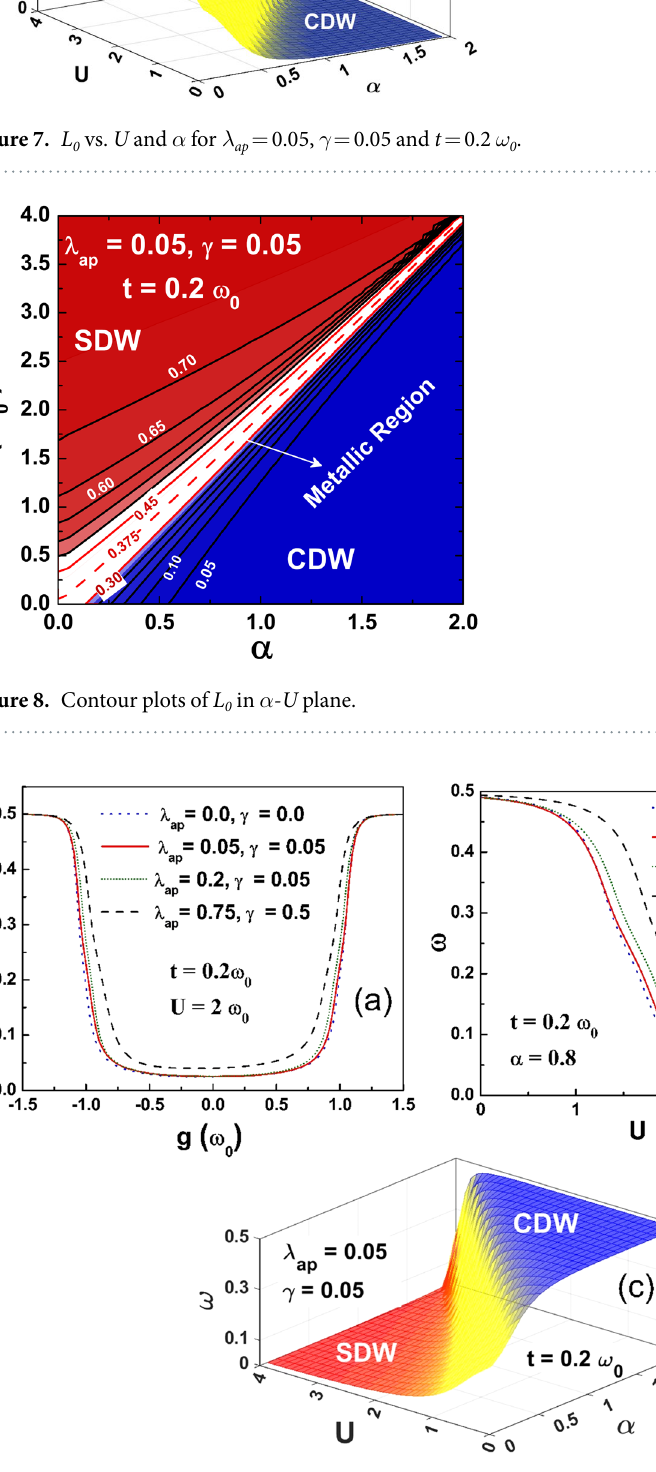
Figure 9. ( a ) Double occupancy ω as a function of g . ( b ) ω as a function of U . ( c ) ω as a function of α and U